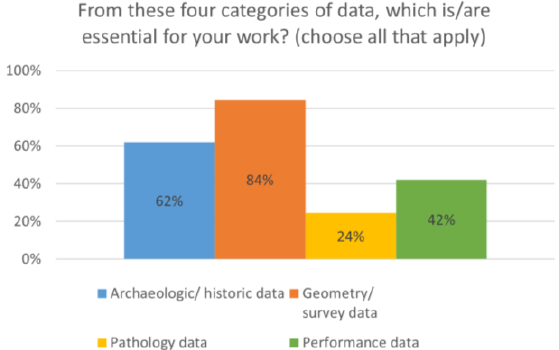
Figure 15: Responses of all the heritage sector participants for data categories they consider essential for their work.